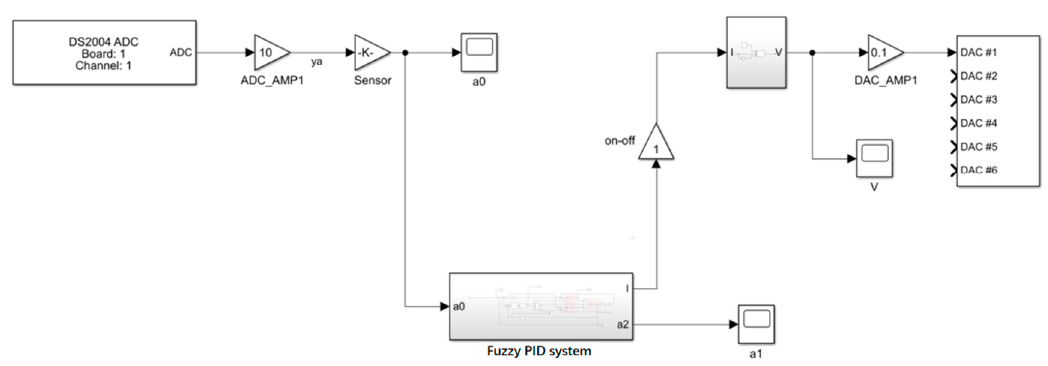
Figure 18. Block diagram of the control system.